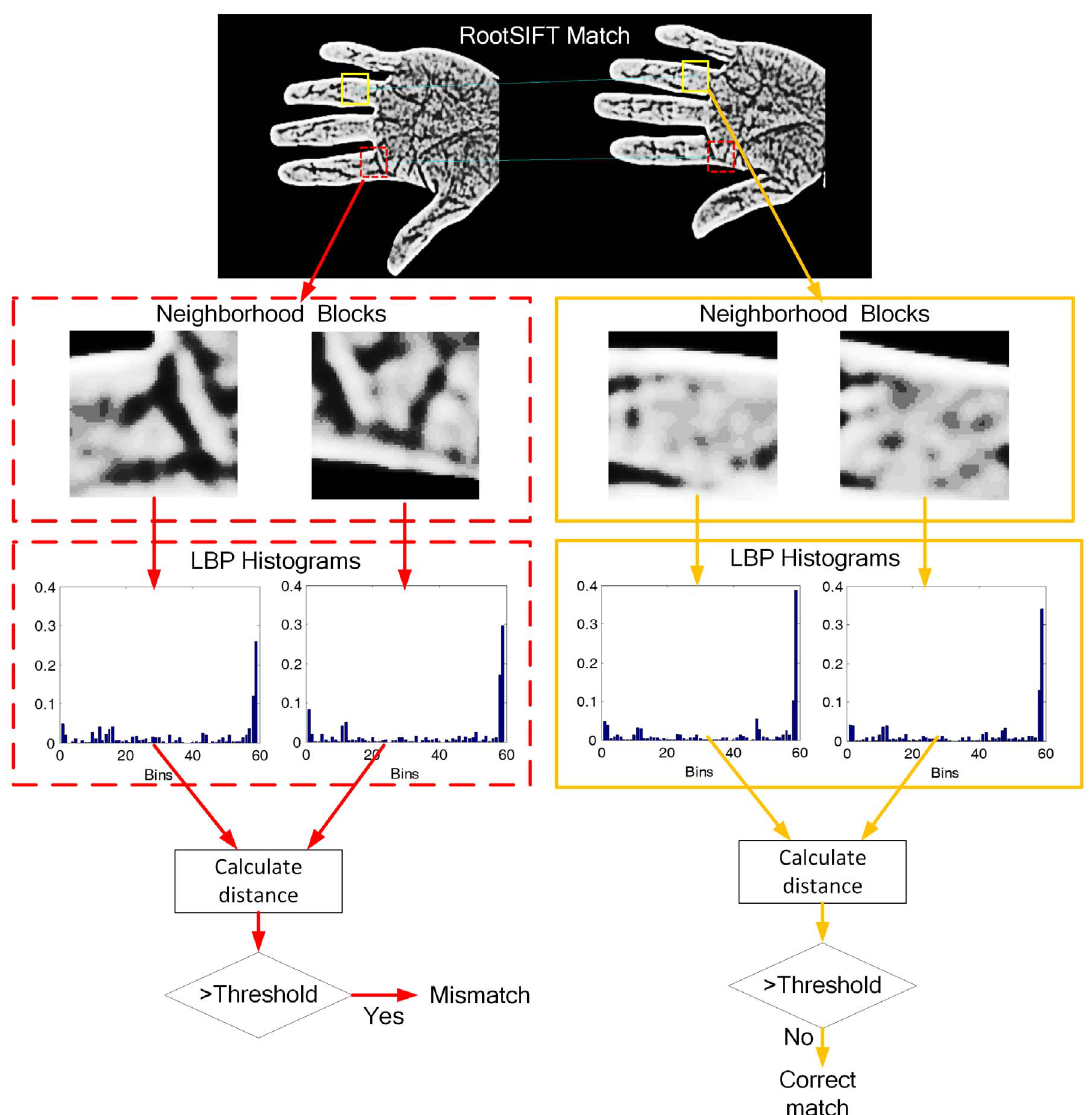
Figure 8. Flow chart of LBP-based mismatching removal.